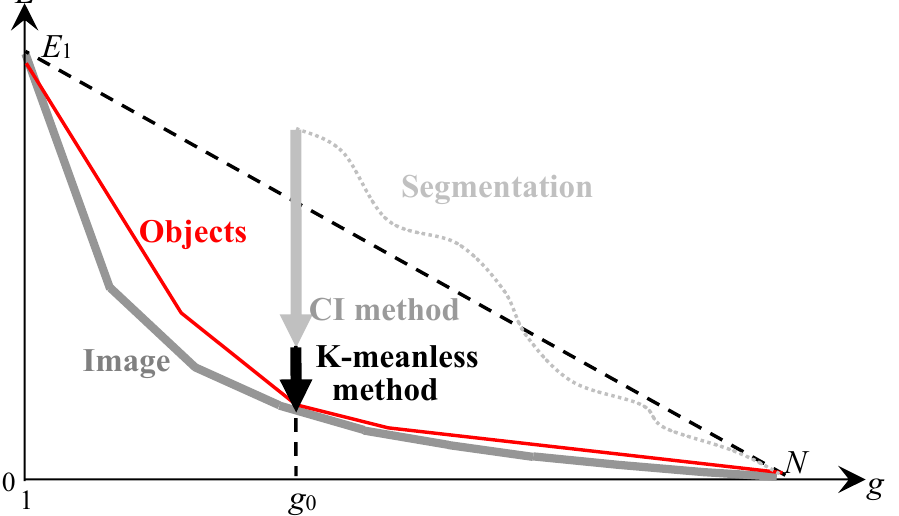
Figure 10. K-meanless method of minimizing the approximation error for a constant number of clusters in image approximation. The limiting lower gray curve, treated as predominantly convex, describes the optimal image approximations. The red convex curve tangent to the gray curve describes the hierarchy of approximations obtained using the K-meanless method.